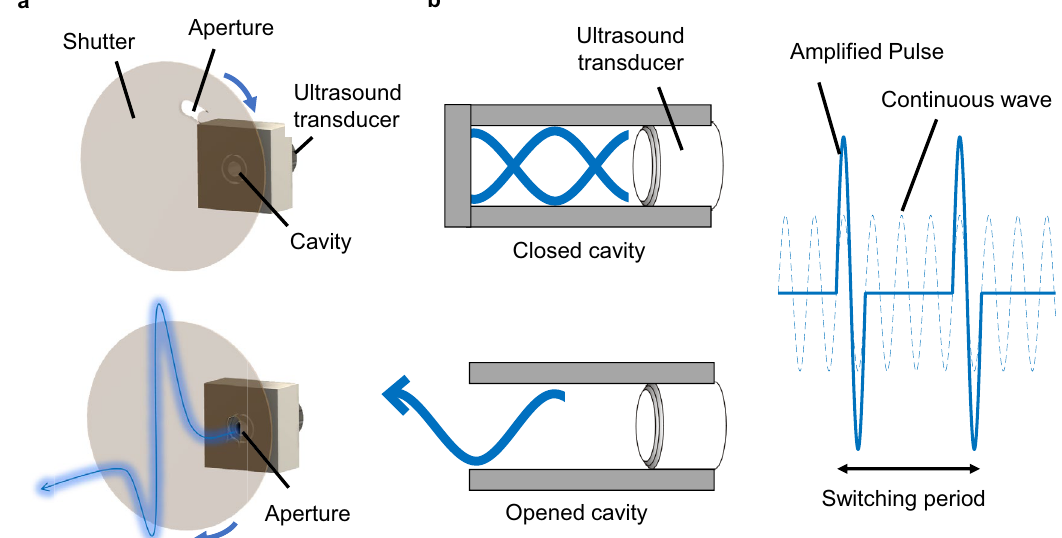
Figure 1. ( a ) Concept of airborne ultrasound pulse amplification using a switchable cavity. ( b ) Illustration of the inside of the cavity when closed and opened. When the stored energy is released into free-space as a pulse, the peak power becomes higher than that of the input continuous waves.